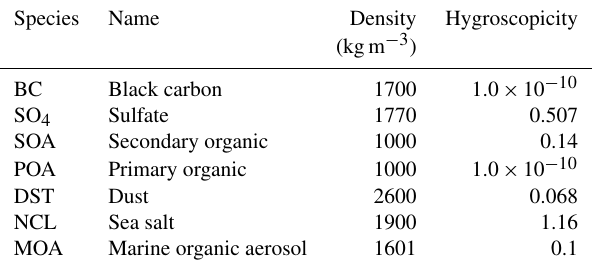
Table 2. Aerosol species and physical